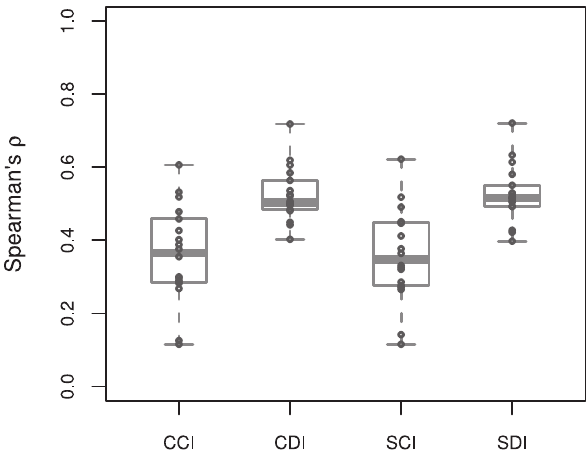
Figure 4. Spearman correlation coefficients ( r ) for position weight matrix (PWM) scanning of transcription factor pairs and their accompanying experimental protein binding microarray (PBM) fluorescence intensities. Transcription factor pair groupings, as in Figure 1, were cross scans of completely-identical pairs (CCI), cross scans of domain-identical pairs (CDI), self scans of completely-identical pairs (SCI), and self scans of domain-identical pairs (SDI). Each point represents a PWM:PBM pairing as described in the Methods.